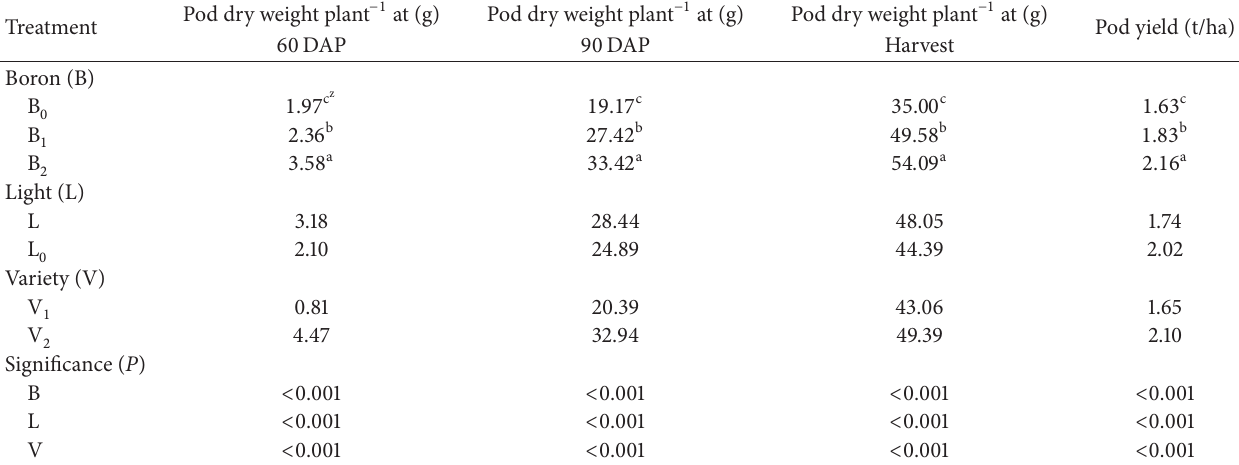
Table 5: Effect of boron and light on pod dry weight plant −1 and pod yield in two peanut varieties (mean of two trials). Treatment